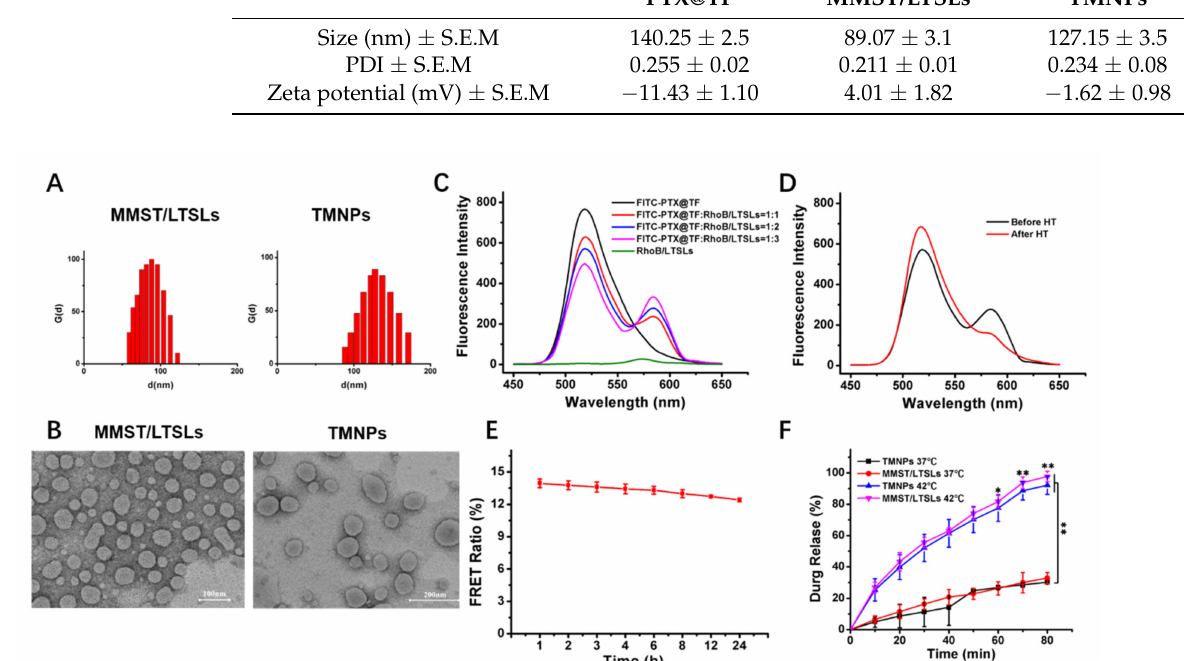
Figure 2. Characterization of TMNPs. ( A ) Size distributions of MMST/LTSLs and TMNPs. ( B ) TEM images of MMST/LTSLs and TMNPs (the scale bar was 100 nm and 200 nm, respectively). ( C ) Fluorescence spectra of fluorescence resonance transfer test with different ratios of FITC-PTX@TF/RhoB-LTSLs. ( D ) Fluorescence emission spectra of FITC-PTX@TF/RhoB-LTSLs with (red) and without (black) HT treatment at 42 ◦ C. ( E ) Serum stability of FITC-PTX@TF/RhoB-LTSLs within 24 h (mean ± SEM, n = 3). ( F ) In vitro drug release of MMST in MMST/LTSLs and TMNPs at 42 ◦ C or 37 ◦ C. (mean ± SEM, n = 3, ** p <